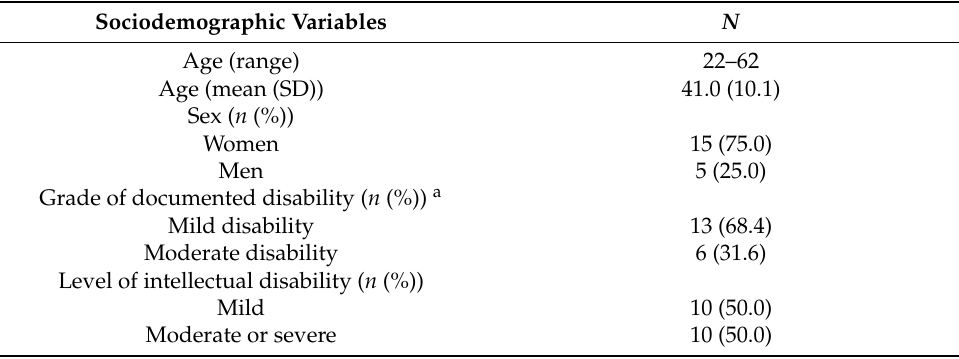
Table 1. Sociodemographic characteristics of the sample ( n =